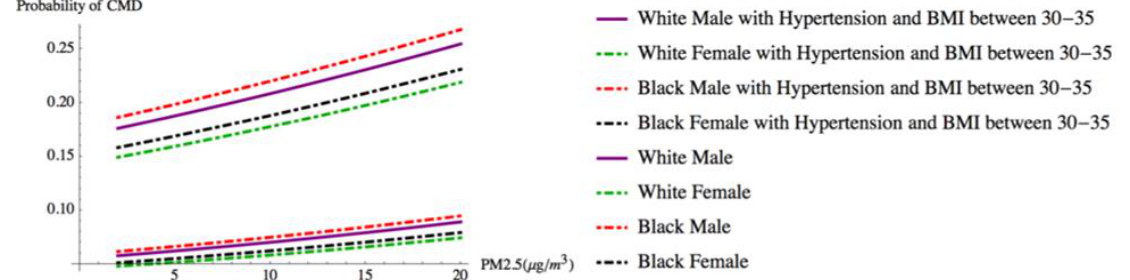
Figure 2. Individuals by race and gender with and without hypertension.